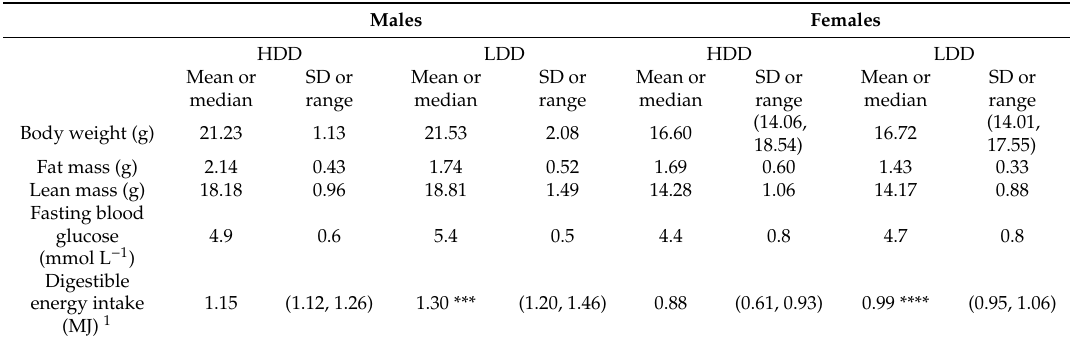
Table 2. Body weight, body composition, and cumulative energy intake at the end of the post-weaning nutritional intervention.